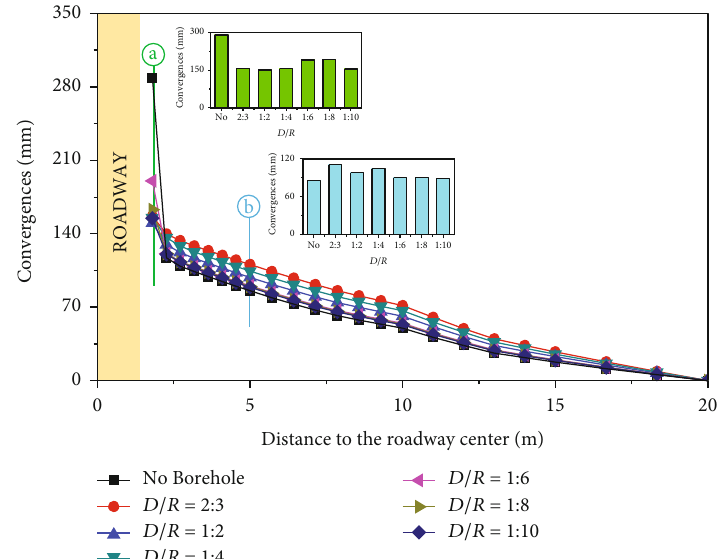
Figure 10: Floor convergence curves under the di ff erent borehole D / R ratios. (a) and (b) give the rib convergence that occurred in the locations of 0 m and 3m from the fl oor surface,